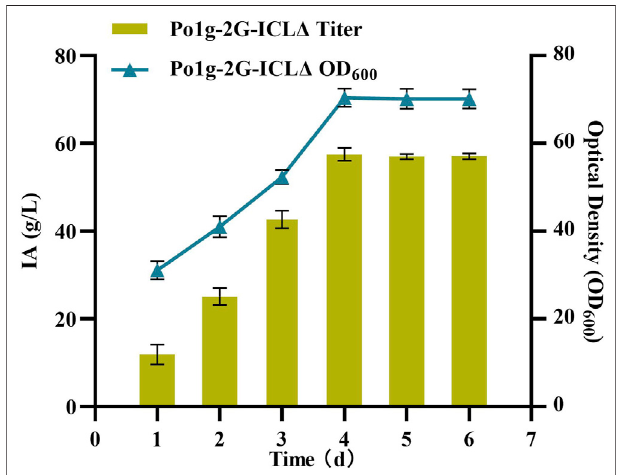
FIGURE 6 | IA production in bioreactor of Y. lipolytica strain expressing the 2G-ICL Δ gene. The titer of IA and biomass were determined by bioreactor fermentation of Po1g-2G-ICL Δ strain in YPO culture. All values presented are the mean of three biological replicates ±